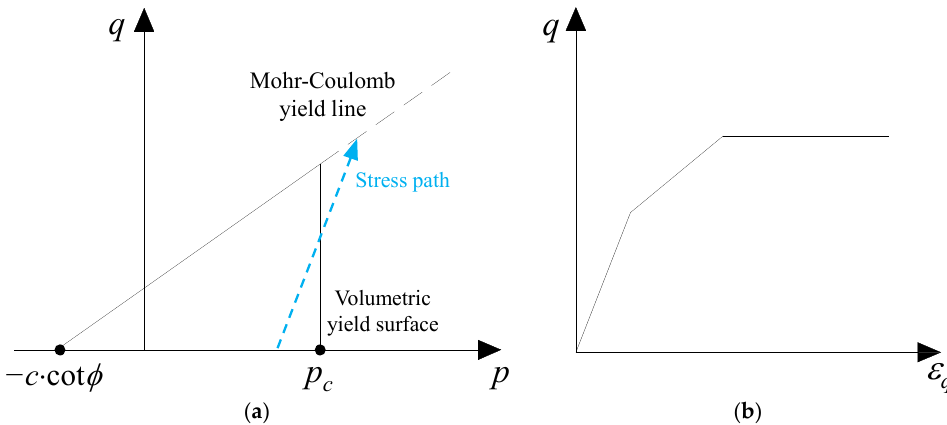
Figure 2. Schematic presentation of the double ‐ yield model: ( a ) yield surface in p – q space; ( b ) stress–strain relationship.